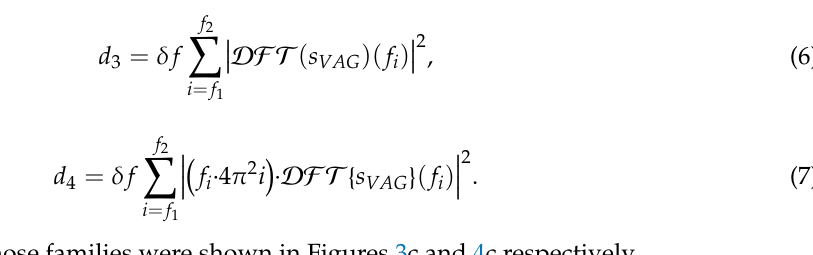
Figure 4. Visualization of the second and the fourth family of features: ( a ) the derivative of the analyzed VAG signal, ( b ) the spectrum of the ( a ), ( c ) the squared spectrum.